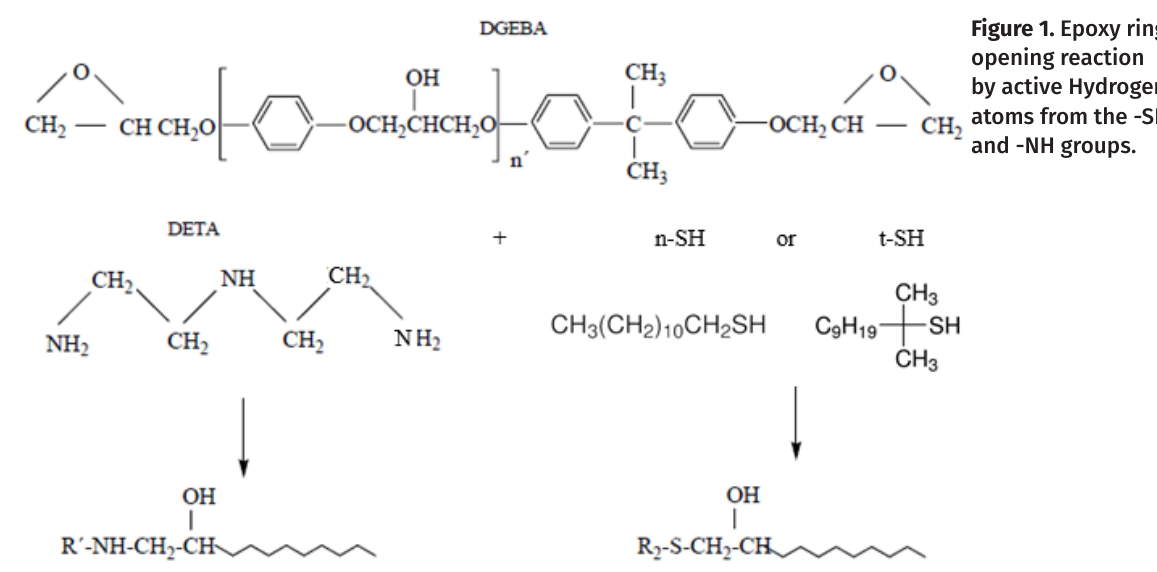
Figure 1. Epoxy ring opening reaction by active Hydrogen atoms from the -SH and -NH